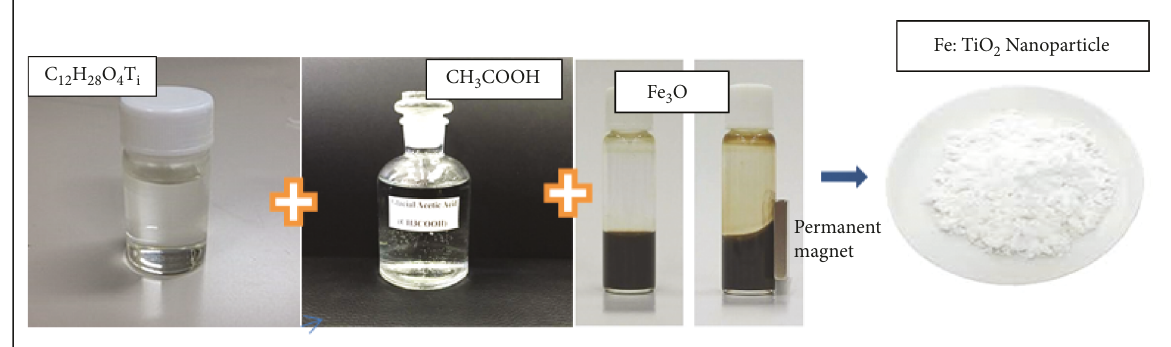
Figure 1: The procedure of material